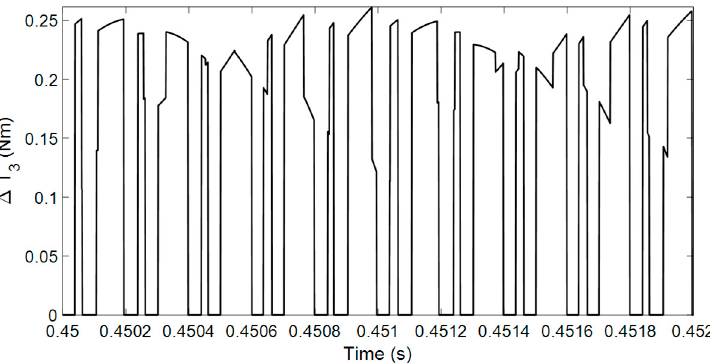
Figure 12. The third torque variation term for cSVM-DTC1 (10 kHz).